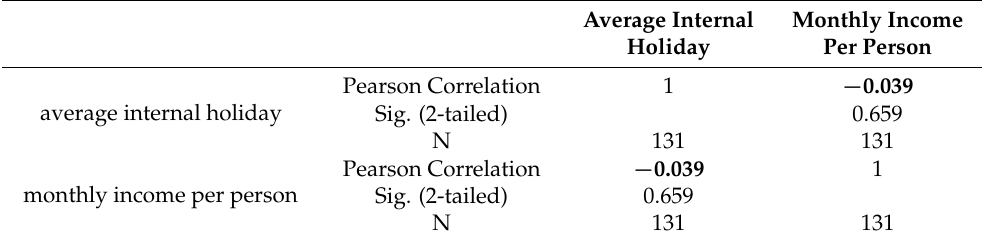
Table 5. Lack of a link between the average length of holiday in the country and the monthly income per person of the